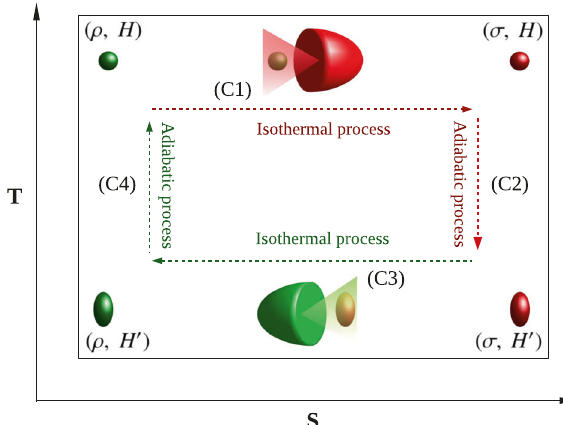
Fig. 1 A schematic of the operations in a traditional Carnot heat engine. The horizontal and vertical axes are the thermodynamic entropy ( S ) and the temperature ( T ). The engine is made up of one working system and two heat baths with inverse temperatures β 1 = 1/ T 1 and β 2 = 1/ T 2 , where β 1 < β 2 . The engine operates in a cycle composed of four thermodynamically reversible steps: (C1) First, an isothermal transformation ( ρ , H ) → ( σ , H ) in interaction with the bath B 1 at inverse temperature β 1 , where the state changes ( ρ → σ ) without updating the system Hamiltonian H . (C2) Second, an adiabatic transformation ð σ ; H Þ ! ð σ ; H 0 Þ without any contact with the baths, where state remain unchanged but the system Hamiltonian modi fi es to H ! H 0 . (C3) Third, an isothermal transfor- mation ð σ ; H 0 Þ ! ð ρ ; H 0 Þ in interaction with the bath B 2 at inverse temperature β